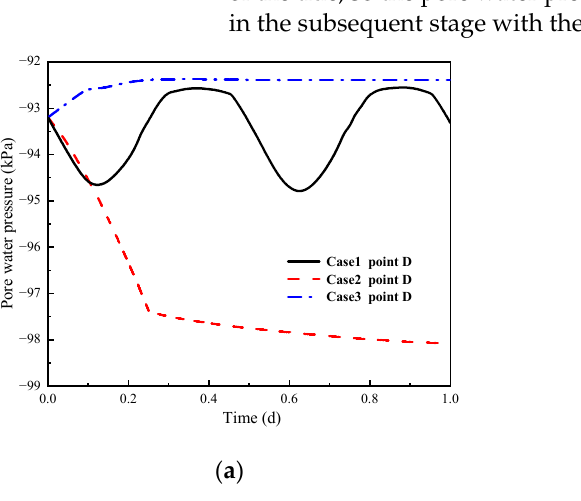
Figure 14. Fluctuation at feature point D under three cases:( a ) Pore water pressure fluctuation. ( b ) Average effective stress fluctuation.